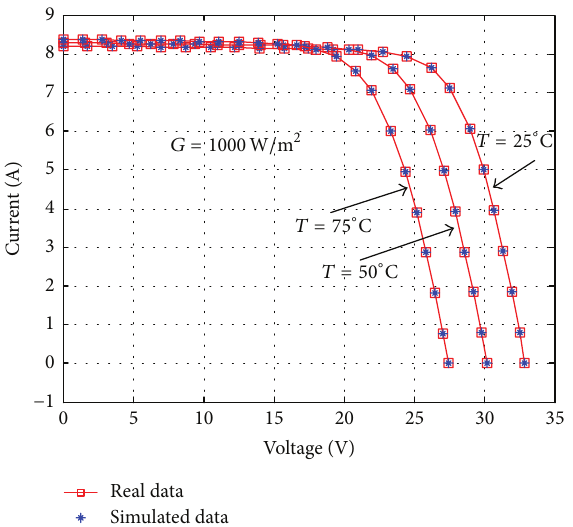
Figure 11: Comparison between real data and the simulated data by PCE for thin-film ST40 at different irradiances.